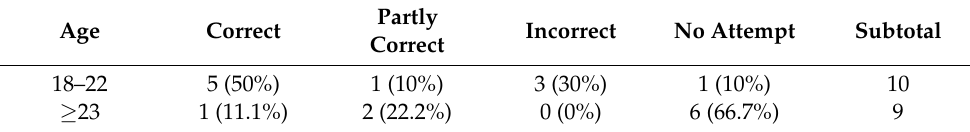
Table 7. Overall performances of students with different ages in the second word problem.